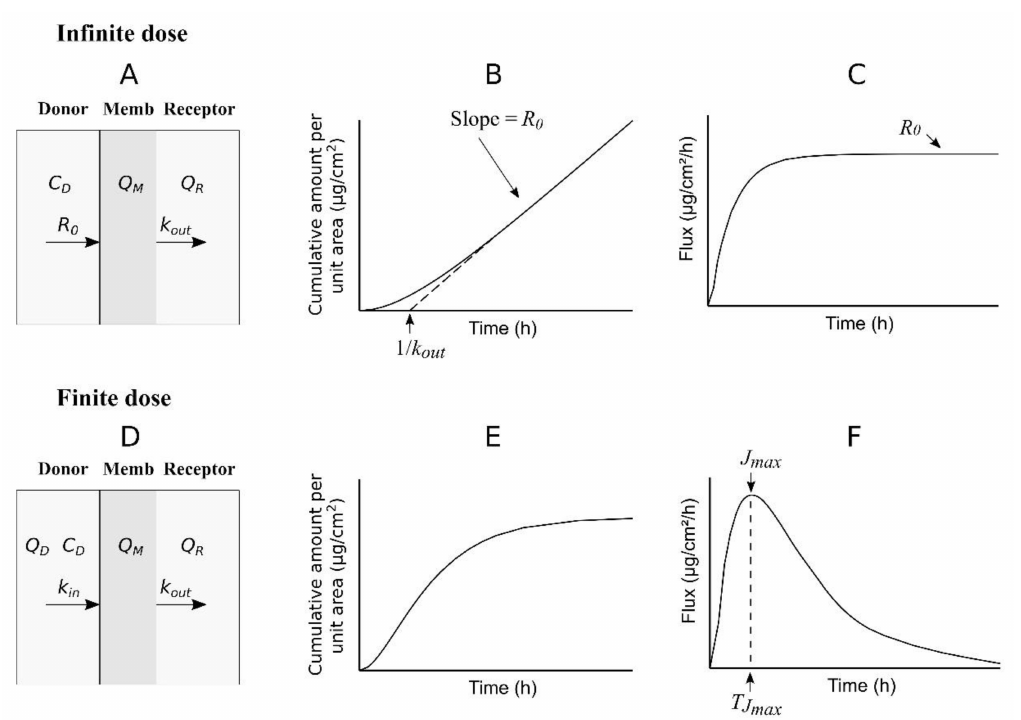
Figure 2. Schematic diagram of the one-compartment model used to describe the transport of a permeant across a membrane under infinite ( A ) and finite ( D ) dose conditions. The expected time profiles of the cumulative amounts of permeant in the receptor chamber and of the permeant flux are shown in graphs ( B , C , E , F